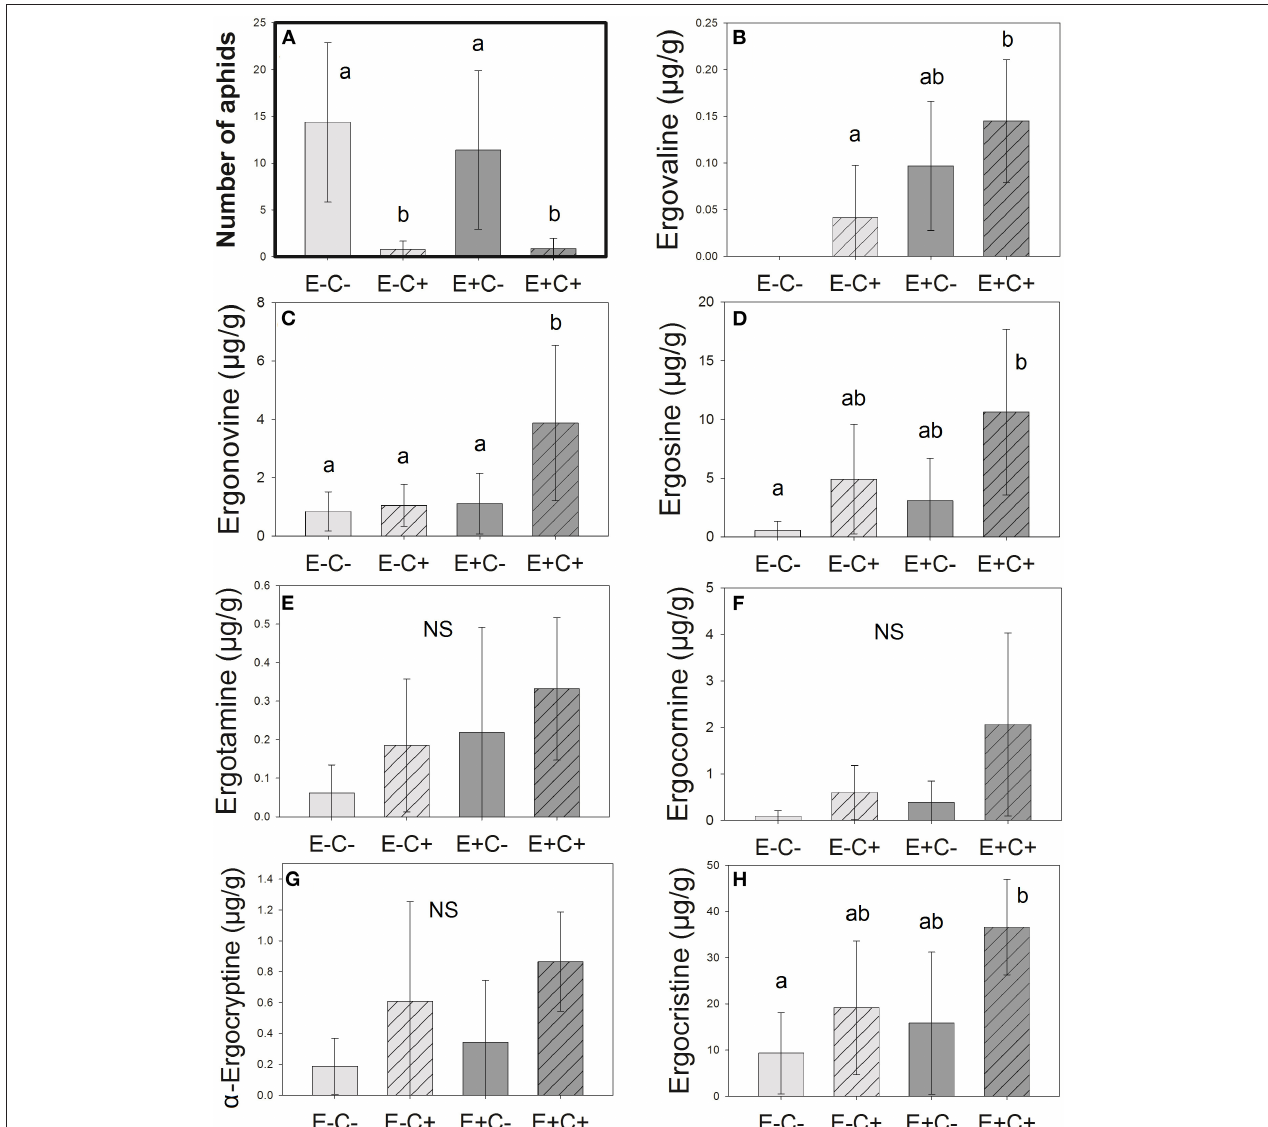
FIGURE 2 | Number of aphids (A) next to the ergot alkaloid concentrations (B–H) in the samples analyzed. Alkaloid concentrations tend to be the highest in plants that are both Epichloë -symbiotic and Claviceps -infected (E + C + ). Letters represent statistically significant differences ( p < 0.05, Tukey adjusted). Error bars represent 95% confidence intervals. N =